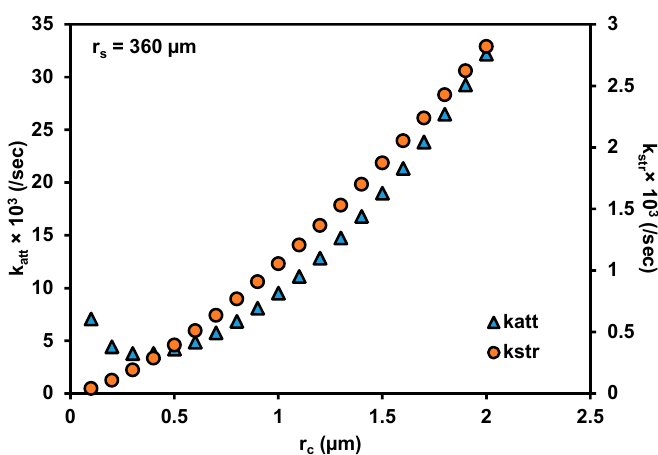
Figure 4. Calculated k att and k str using Equations (5) and (6) at varied r c (0.1 µm interval) and r s = 360 µm.